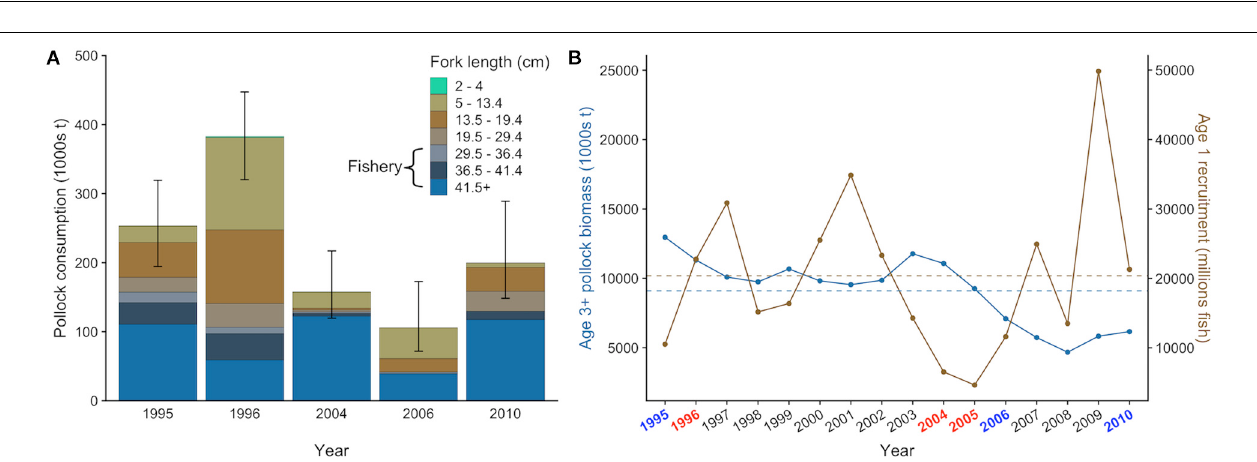
FIGURE 3 | Mean energy intake (A) and prey consumption (B) by northern fur seals from the Pribilof Islands from May to December. In (A) , the blue denotes the mean contribution of walleye pollock to the total energy intake for years where diet estimates were available. In (B) , prey from similar species or type (squid) were combined into a single prey category for ease of visualization. Error bars are standard deviations that represent the uncertainty in the actual population size (A) or 95% confidence intervals that represent uncertainty in diet estimates and population size (B) .